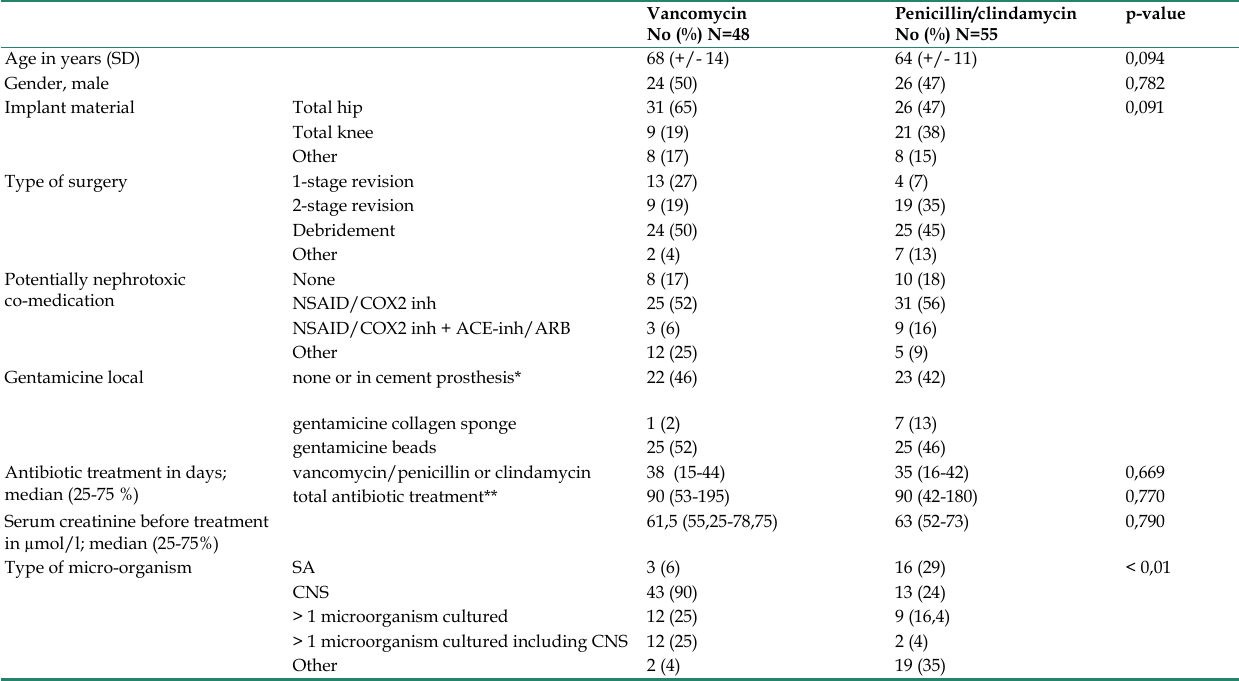
Table 1. Patient